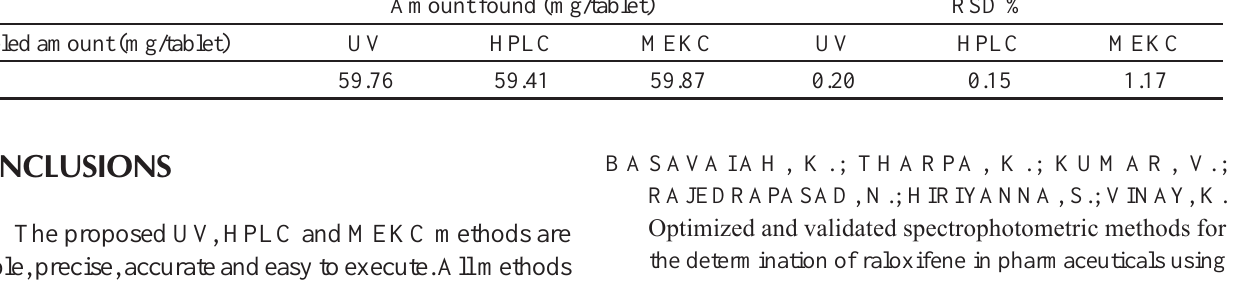
TABLE VI - Percent label amounts of hydrochloride raloxifene in tablets Amount found